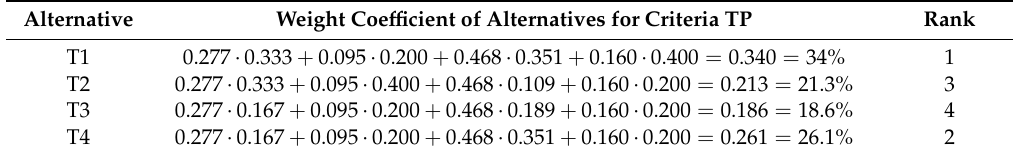
Table 6. Alternative ranking by technical parameters.